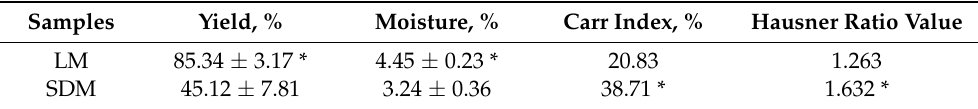
Table 4. Physical microcapsules’ parameters.